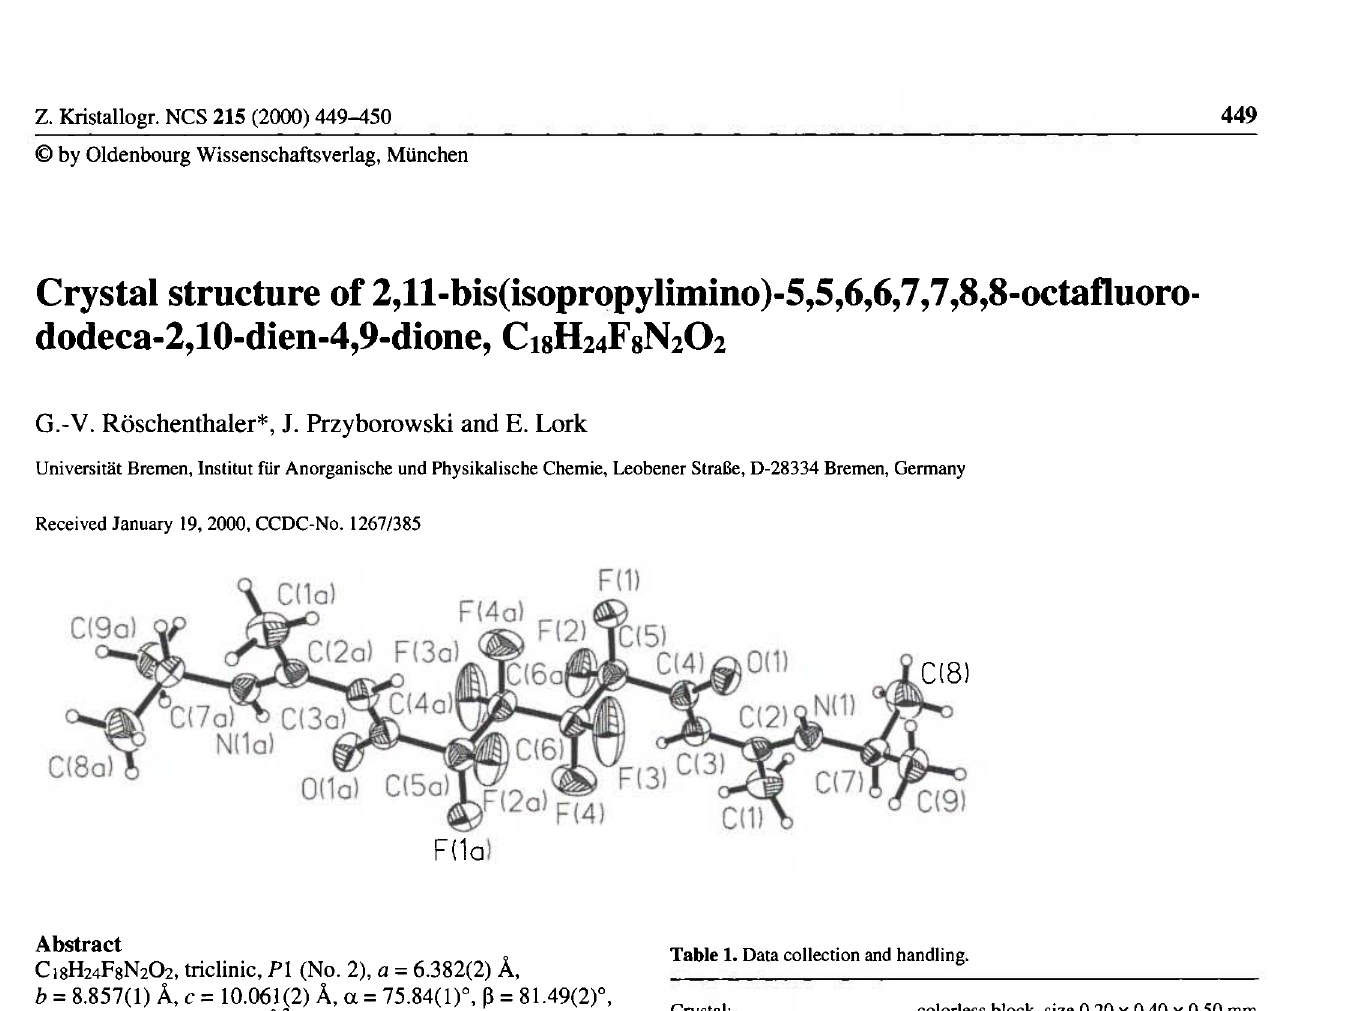
Table 1. Data collection and handling.